Question: Which visualization type does this figure use?
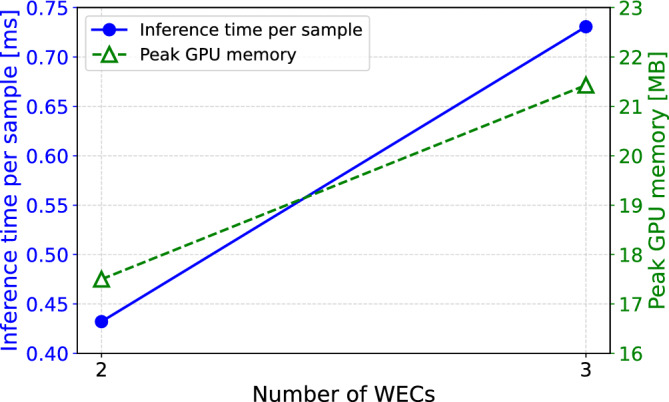
Answer: line